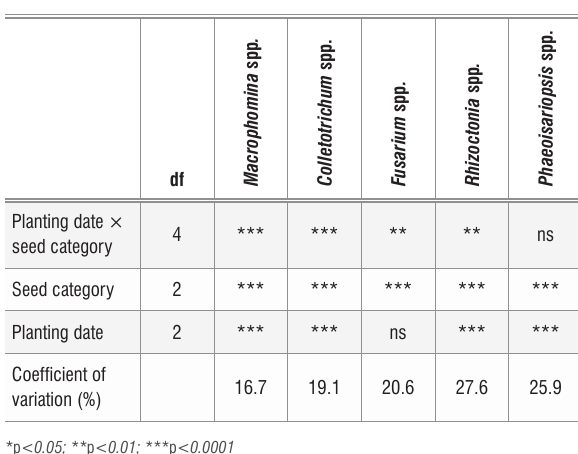
Effect of planting date on seed discolouration